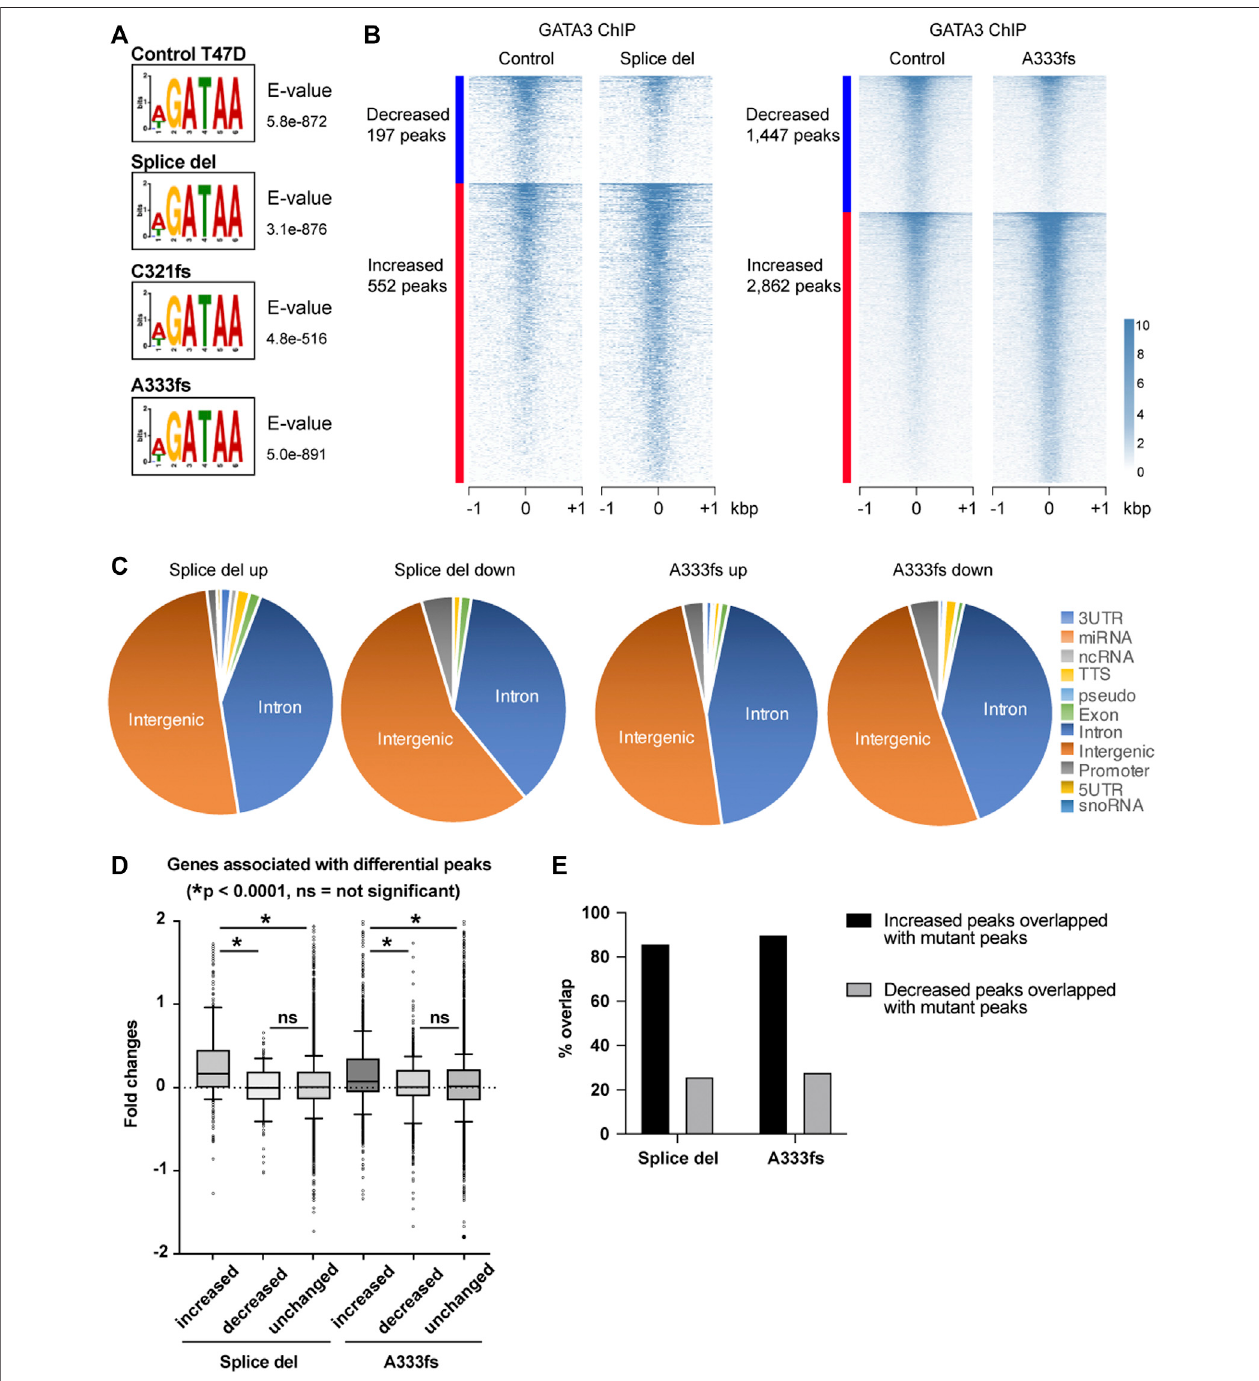
FIGURE 5 | GATA3 re-distribution in GATA3 mutant cells. (A) The most signi fi cantly enriched motif by MEME ChIP analysis. (B) Heatmap showing decreased or increasedGATA3bindinginSplicedel(left)orA333fsmutantcells. (C) Genomiclocalizationofdifferentialpeaks. (D) CorrelationanalysisofGATA3differentialpeaksand geneexpression.Increased, decreased, and unchangedpeaks areassignedtonearestgenes.BoxplotsshowthefoldchangesofeachGATA3peak groupassociated genes. Fold changes were calculated between Splice del and control T47D cells or A333fs and control T47D cells. (E) Overlap between differential peaks and Splice del or A333fs